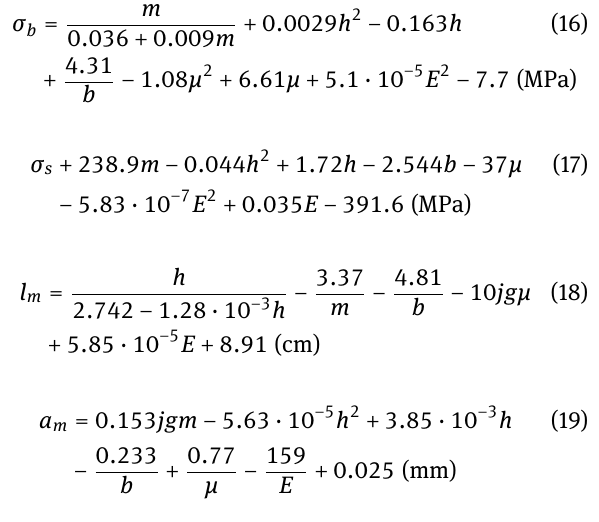
dependence for maximum compressive stress in concrete σ b